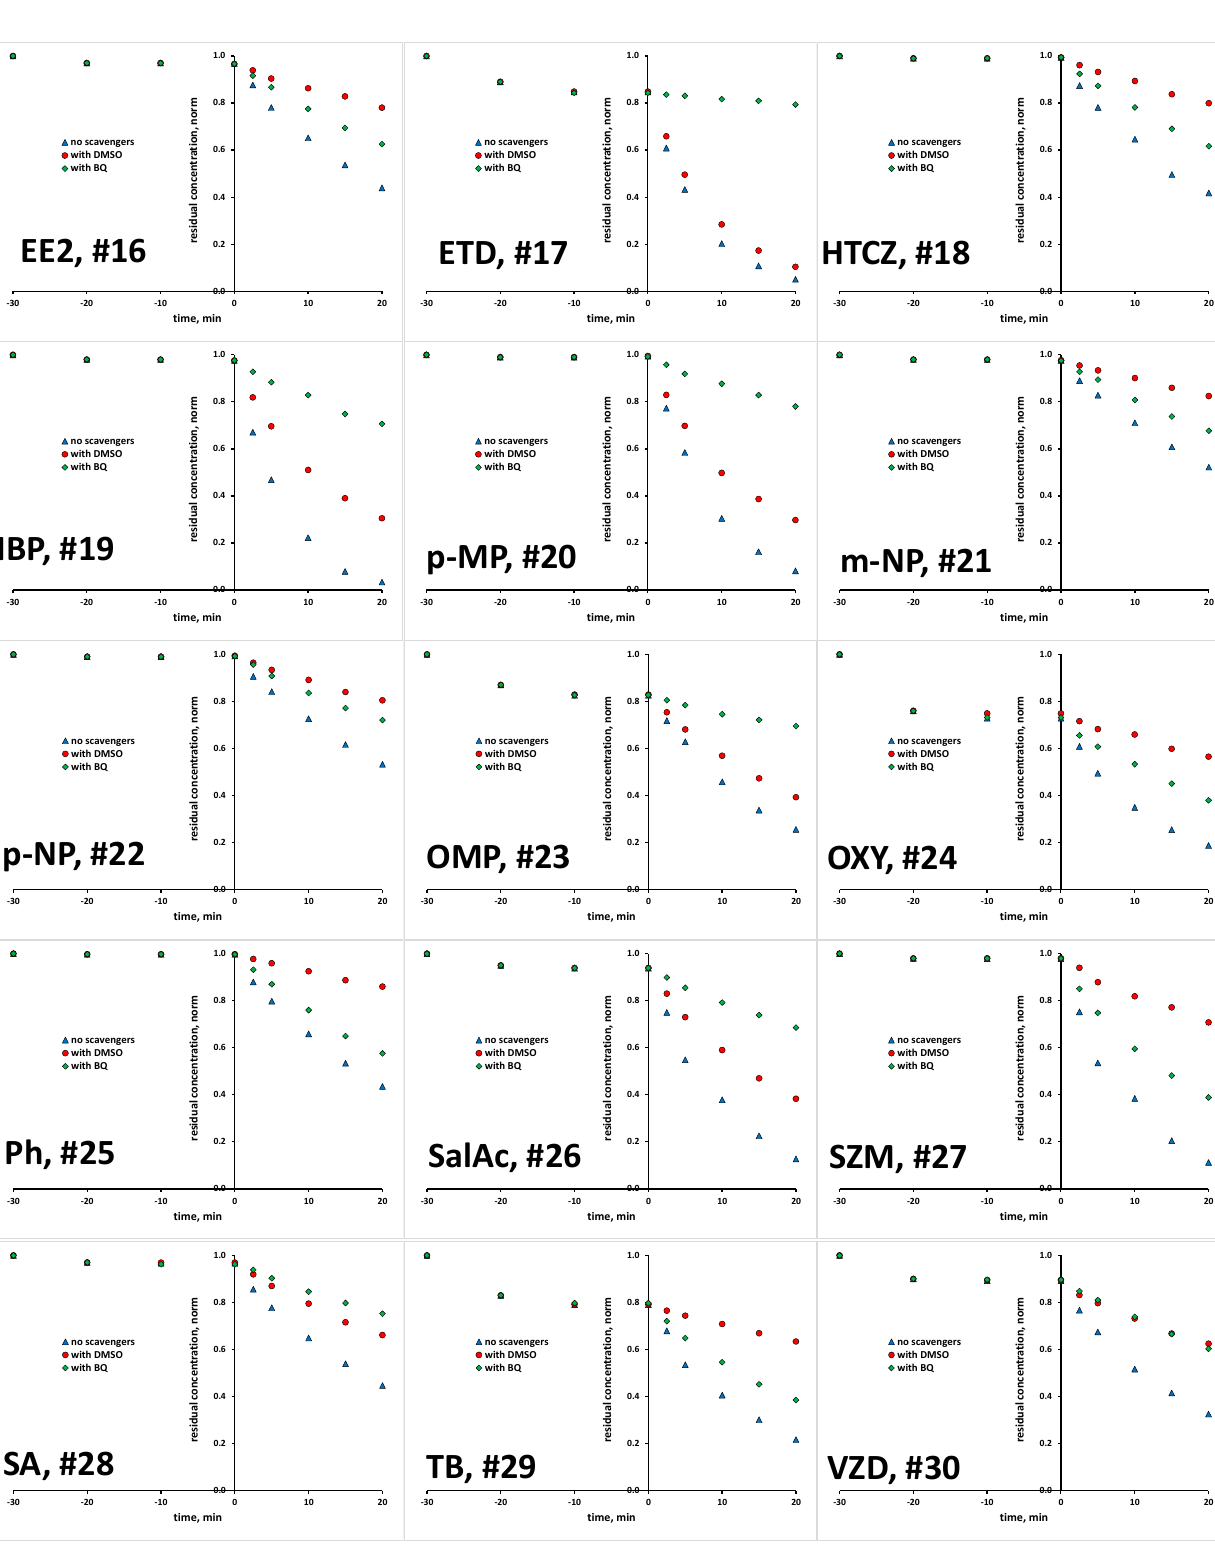
) vs. that driven by O 2 • − ( 𝑀 ) (cid:2892)(cid:2899)• (cid:2899) (cid:3118) • (cid:3127)